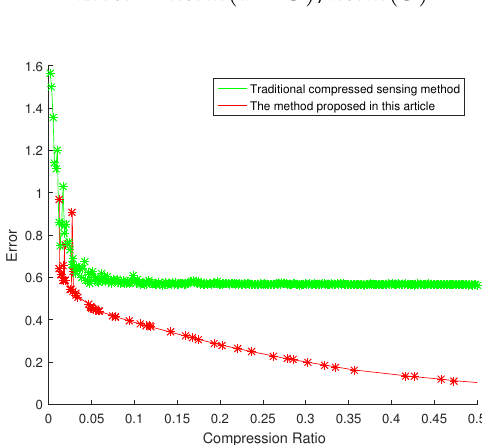
Figure 17. Experimental results of different